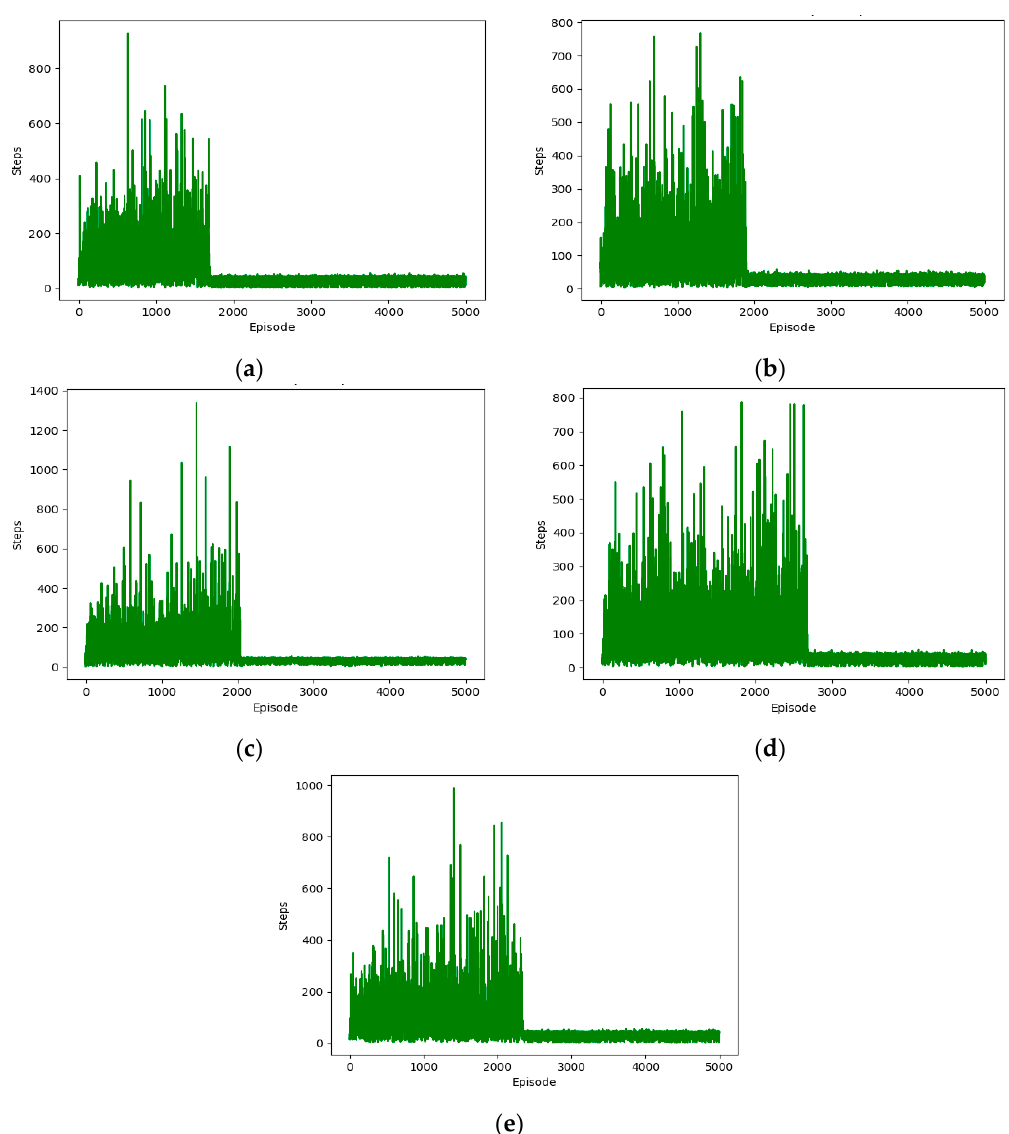
Figure 11. Path optimization learning progress status of Q-Learning: ( a ) 1st test; ( b ) 2nd test; ( c ) 3rd test; ( d ) 4th test; ( e ) 5th test.